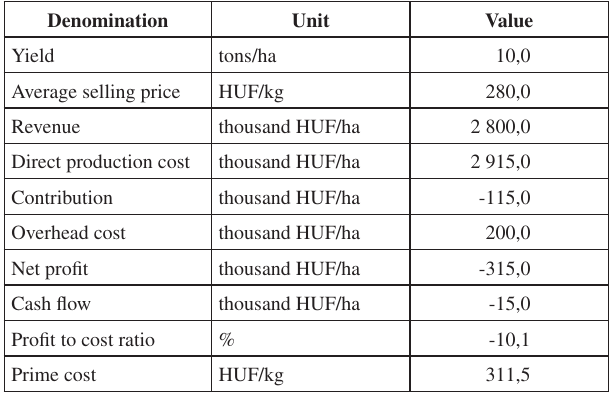
Table 3: Revenue and Profitability of a Raspberry Orchard Cultivated on a Good Standard in a Good Year Regarding a Yield of 10 tons per One